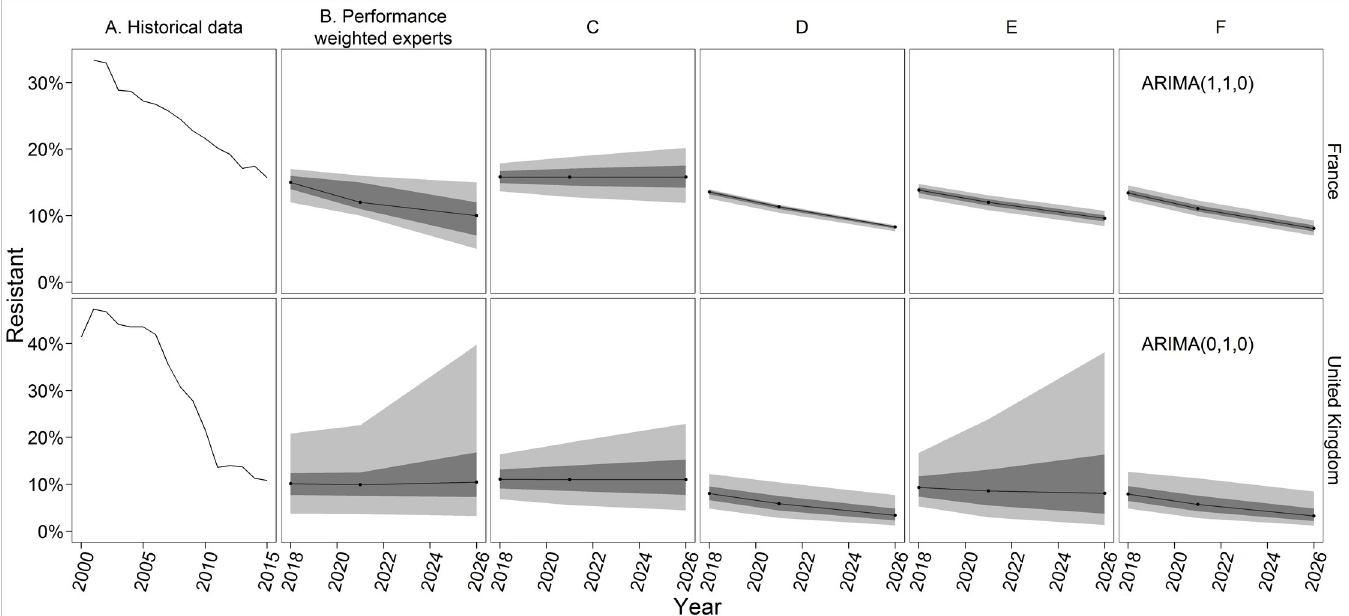
Fig 4. PW and forecasting results for MRSA in France and United Kingdom. All forecasts begin with 2018, 3 years after the most recent historical data. Black lines indicate the median, dark grey indicates the 50% prediction interval, and light grey indicates the 90% predication interval. The experts only assessed 2018, 2021, and 2026.